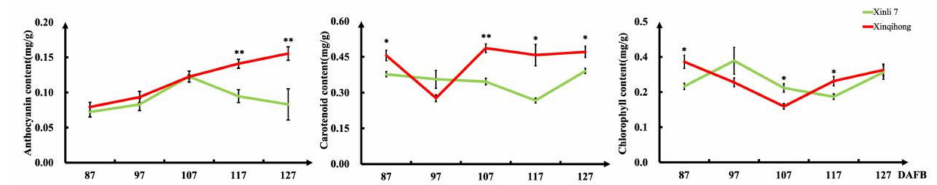
Figure 2. Pigment content of fruit peel at different stages of fruit development. * Significant differences at p < 0.05; ** Significant differences at p < 0.01.